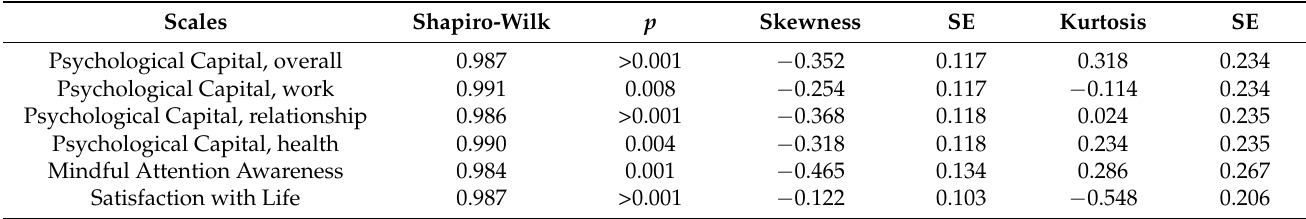
Table 2. The data distribution for the SWLS, the PCQ-12, and the